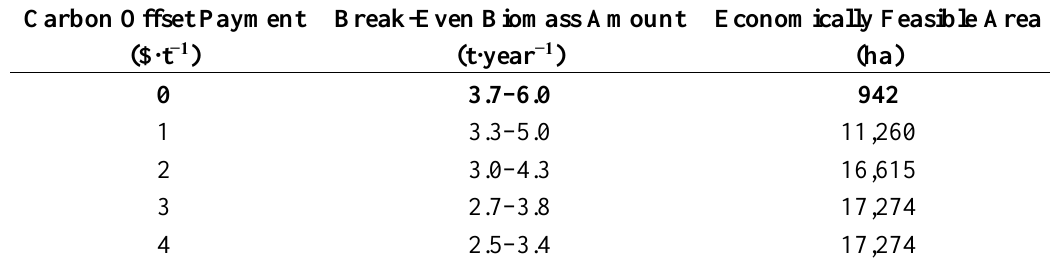
Figure 8. Ranges of break-even biomass amounts associated to different carbon offset payments. Table 3. Scenario IV results: carbon offset payment sensitivity analysis and associated economically feasible area. (Bold font indicates baseline